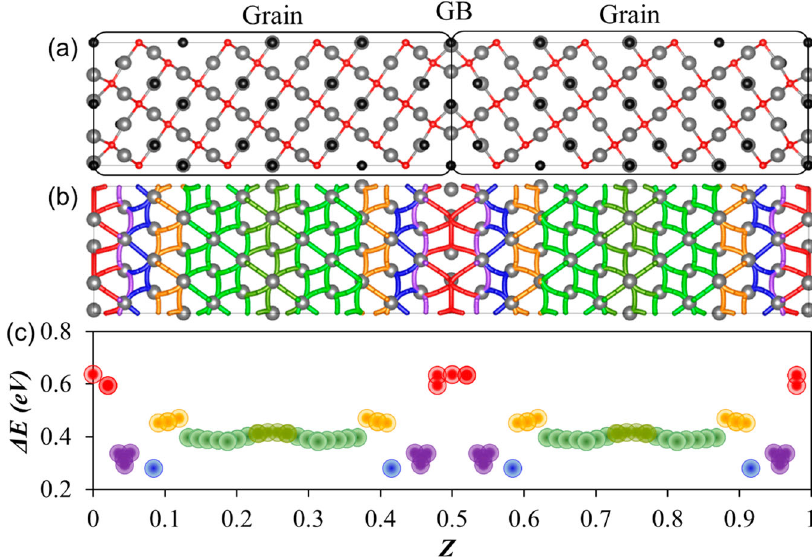
Fig. 3 Li-ion migration map of the Σ 3(111) GB. a GB atomistic model. b Li-ion migration map with an energy barrier cutoff of 0.64 eV. c Li-ion migration energy barriers depending on the relative coordinate (Z) in the direction perpendicular to the GB. The Li-ion migration pathways in ( b ) are colored according to the magnitude of the energy barriers presented in ( c ). Color code of the atomic species in ( a ) as in Fig.